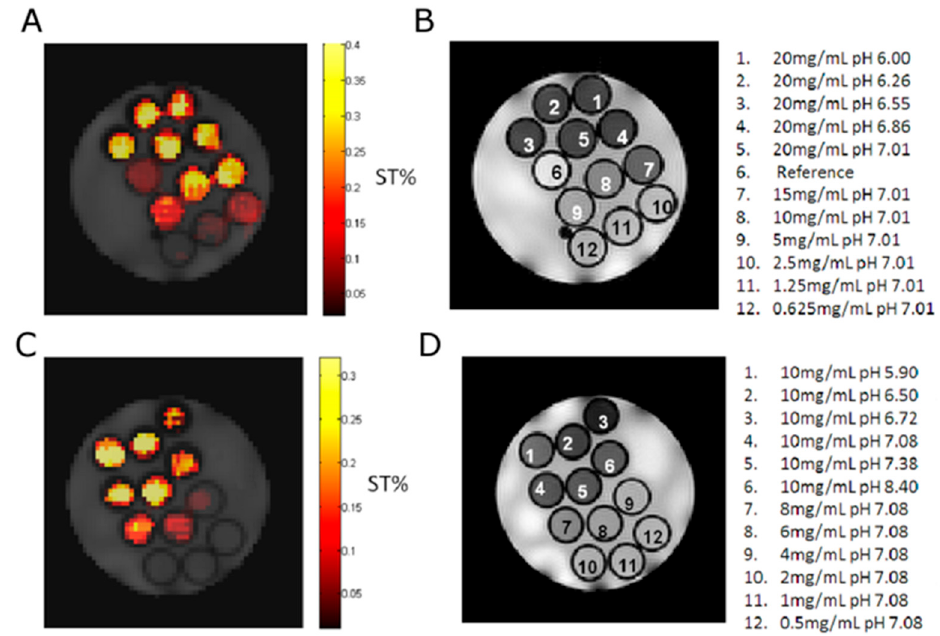
Figure 5. T 2w ( A , B ) and ST% maps ( C , D ) of TbDO3A-MCM-41 ( A , C ) and TbDO3A-SBA-15 ( B , D ) MSNs at variable concentration or pH values.